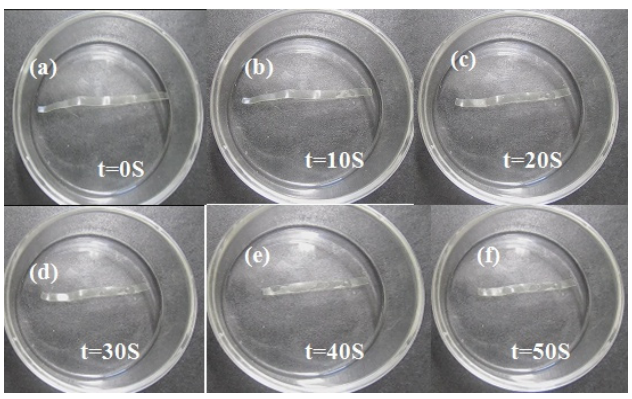
Figure 11. Shape recovery of the extended PCL-S3 sample at 60 °C. The shape recovery takes place slowly and is completed up to ~80% after 50 s; a much slower rate than that recorded for